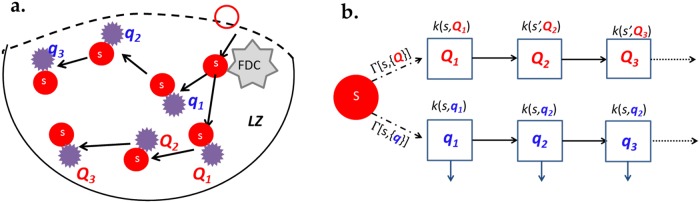
A sketch of the possible pathways of B-Tfh cell encounters.A: Each B cell has a probability of encountering different sets of Tfh cells, e.g Tfh cells with sequences {q1, q2, q3..} or alternately encounters involving Tfh cell sequences {Q1, Q2, Q3,..}. B: Each such B-Tfh cell “path” can be represented by sequences of individual B-Tfh reactions as shown.